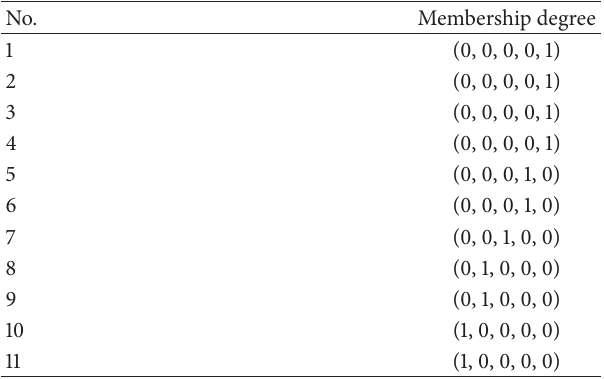
Table 8: Membership function of soil media ( 𝑆